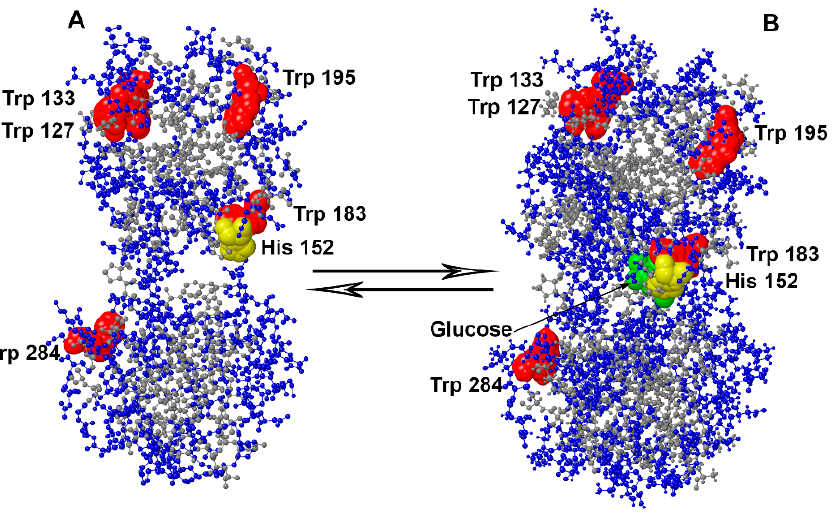
Figure 1. Spatial structure of D-glucose/D-galactose-binding protein (GGBP) in apoform panel ( A ) and holoform panel ( B ) according to X-ray structural analysis [33]. Polar GGBP residues are shown in blue; non-polar protein residues are in gray; GGBP tryptophan residues, four of five of which are located in the C-terminal domain of the protein, are shown in red; histidine residue 152 is shown in yellow (His152/Cys substitution provides linking of the fluorescent dye BADAN in the active center of GGBP); and the glucose molecule is shown in green.